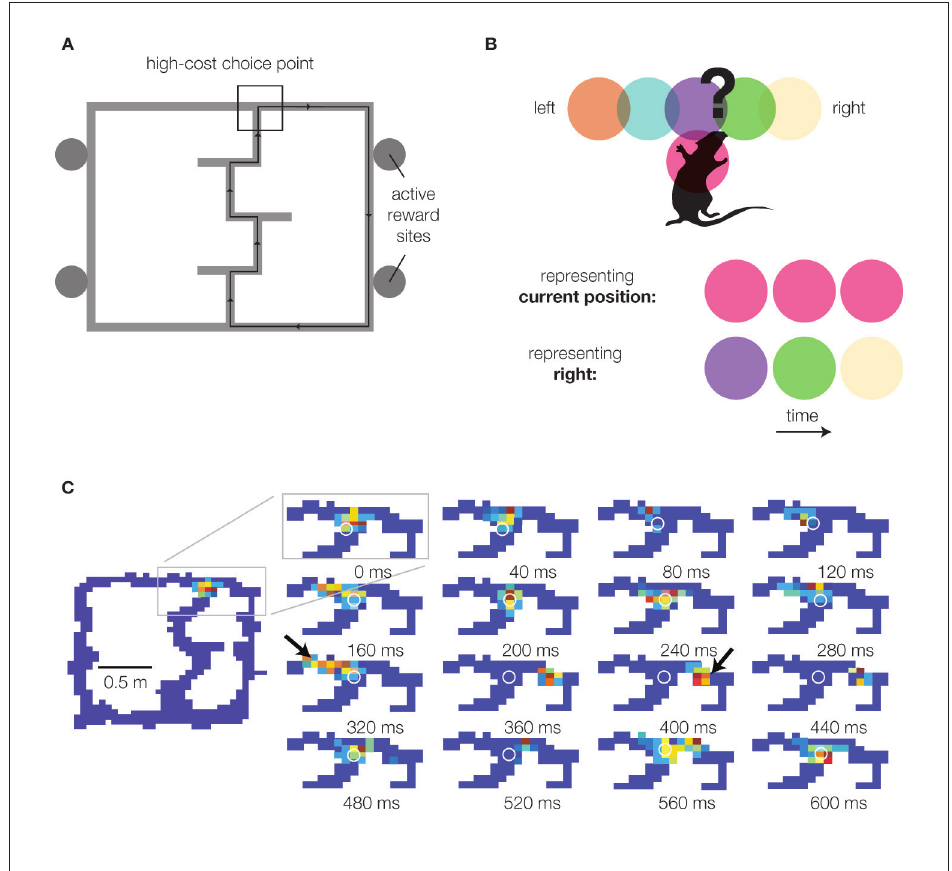
which cells are active at any given time, we can infer what location is being represented. If the rat is simply representing its current location, the red cell will be active. In contrast, when the rat pauses at the choice point, activity from the purple, green, and yellow cells might be observed in sequence. This indicates the rat is representing a location distant from its current location (the right maze arm in this example) – a key component of planning. (C) Sequence of place representations decoded from actual neurons as the rat (location indicated by the white o) pauses at the final choice point. Red indicates high probability, blue indicates low probability. Note how even though the rat (o) stays stationary, the decoded probability sweeps down the left arm of the maze, then the right (arrows). Data from Johnson and Redish